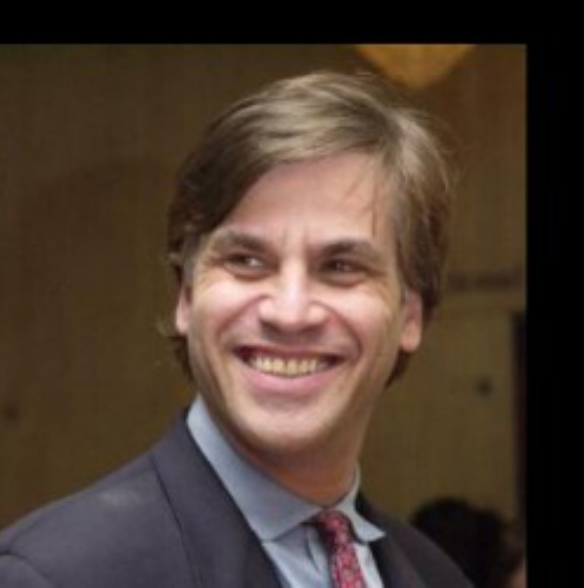
Figure 1. Example image № 0002 of Aaron Sorkin from the LFW